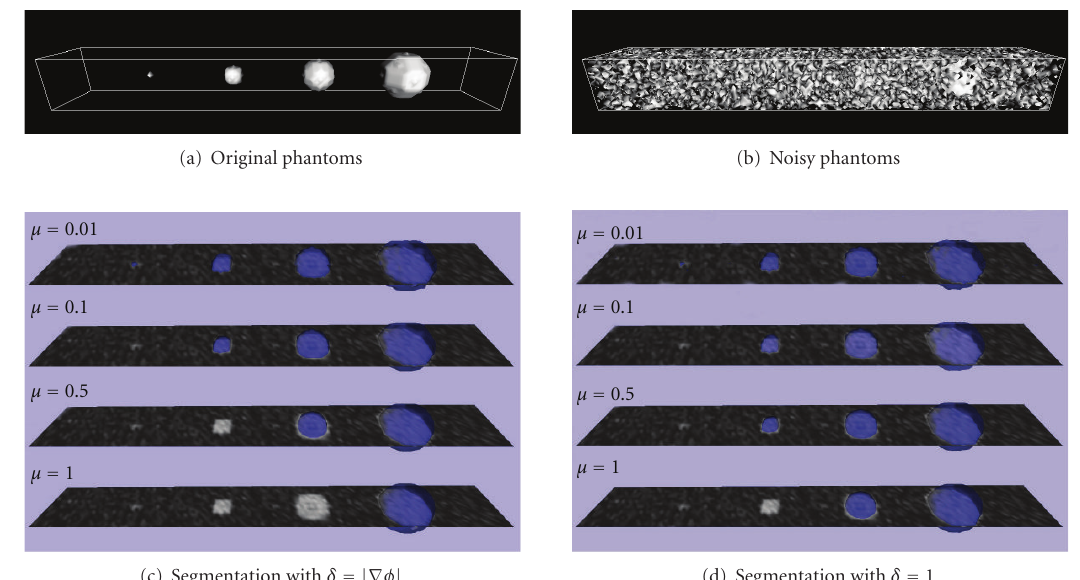
Figure 3: Graphical representation of the calibration of μ . Noisy spheres of di ff erent radii (1, 3, 5, and 7 voxels) segmented using di ff erent values of scale parameter. Figures (c) and (d) show the noisy data in a cutting plane and the segmentation (blue) in surface rendering. (a) Original spheres. (b) Noisy spheres (Gaussian noise with mean value 0 and standard deviation 50). (c) Segmentation with δ = |∇ φ | . (d) Segmentation with δ = 1. Steady state after 1000 iterations for μ ≤ 0 . 1, otherwise 7000 (a) and 9000 (b)